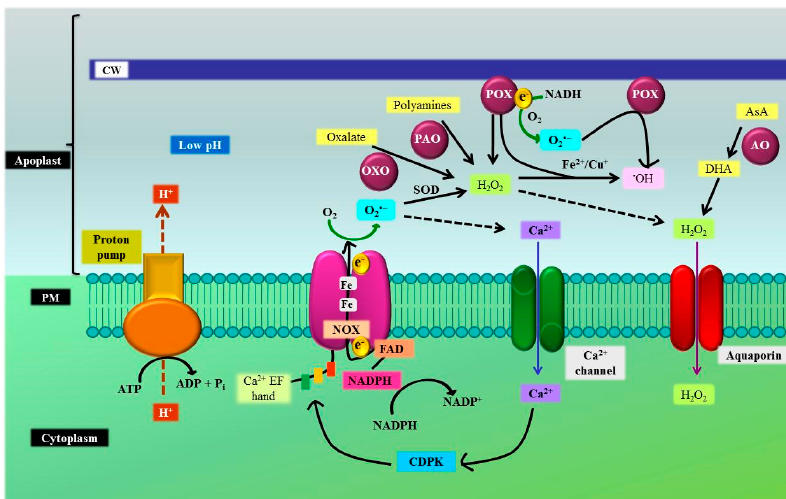
Figure 6. ROS production by the plasma membrane, apoplast, and cell wall under abiotic stress. The plasma membrane (PM) localized NADPH oxidase consists of two cytoplasmic binding sites: 1) Flavin adenine dinucleotide (FAD) and nicotinamide adenine dinucleotide phosphate (NADPH) and 2) Ca 2+ binding EF-hand motifs. The NADPH oxidase transfer electron from the cytosolic NADPH to the apoplast via cytochrome (Fe) present in the channel is formed by NADPH oxidase transmembrane domains and reduces O 2 to O 2 • – . In the apoplast, O 2 • – either spontaneously (due to low pH maintained through the proton pump) or by the action of SOD disproportionates into H 2 O 2 . O 2 • – induces the Ca 2+ influx through the Ca 2+ channel which moves to the Ca 2+ binding EF-hand motif of NADPH oxidase via the calcium-dependent protein kinase (CDPK) and activates the NADPH oxidase leading to ROS production. Other enzymes such as cell wall (CW) bound peroxidases (POX) and apoplast localized amine oxidases (AO), polyamine oxidases (PAO), and oxalate oxidases (OXO) in the presence of specific substrates result in ROS generation. POX in the presence of NADP reduces O 2 to O 2 • – which dis-mutates to H 2 O 2 . Similarly, AO breaks down AsA to dehydroascorbate (DHA), which in turn generates H 2 O 2 . OXO and PAO partake in H 2 O 2 formation in the presence of oxalate and polyamine, respectively. H 2 O 2 is converted into • OH either through the Fenton reaction in the presence of redox metals or by the action of POX. H 2 O 2 produced in the apoplast also moves to the cytoplasm through aquaporins and participates in